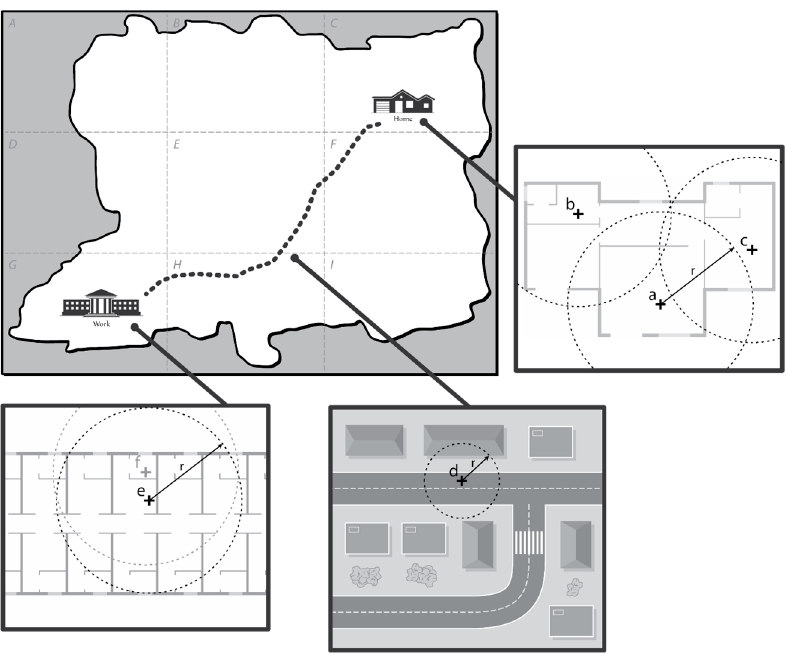
Figure 3. Map of a fictional city. Table 4. Recording location information in the location table with PoiTrace.